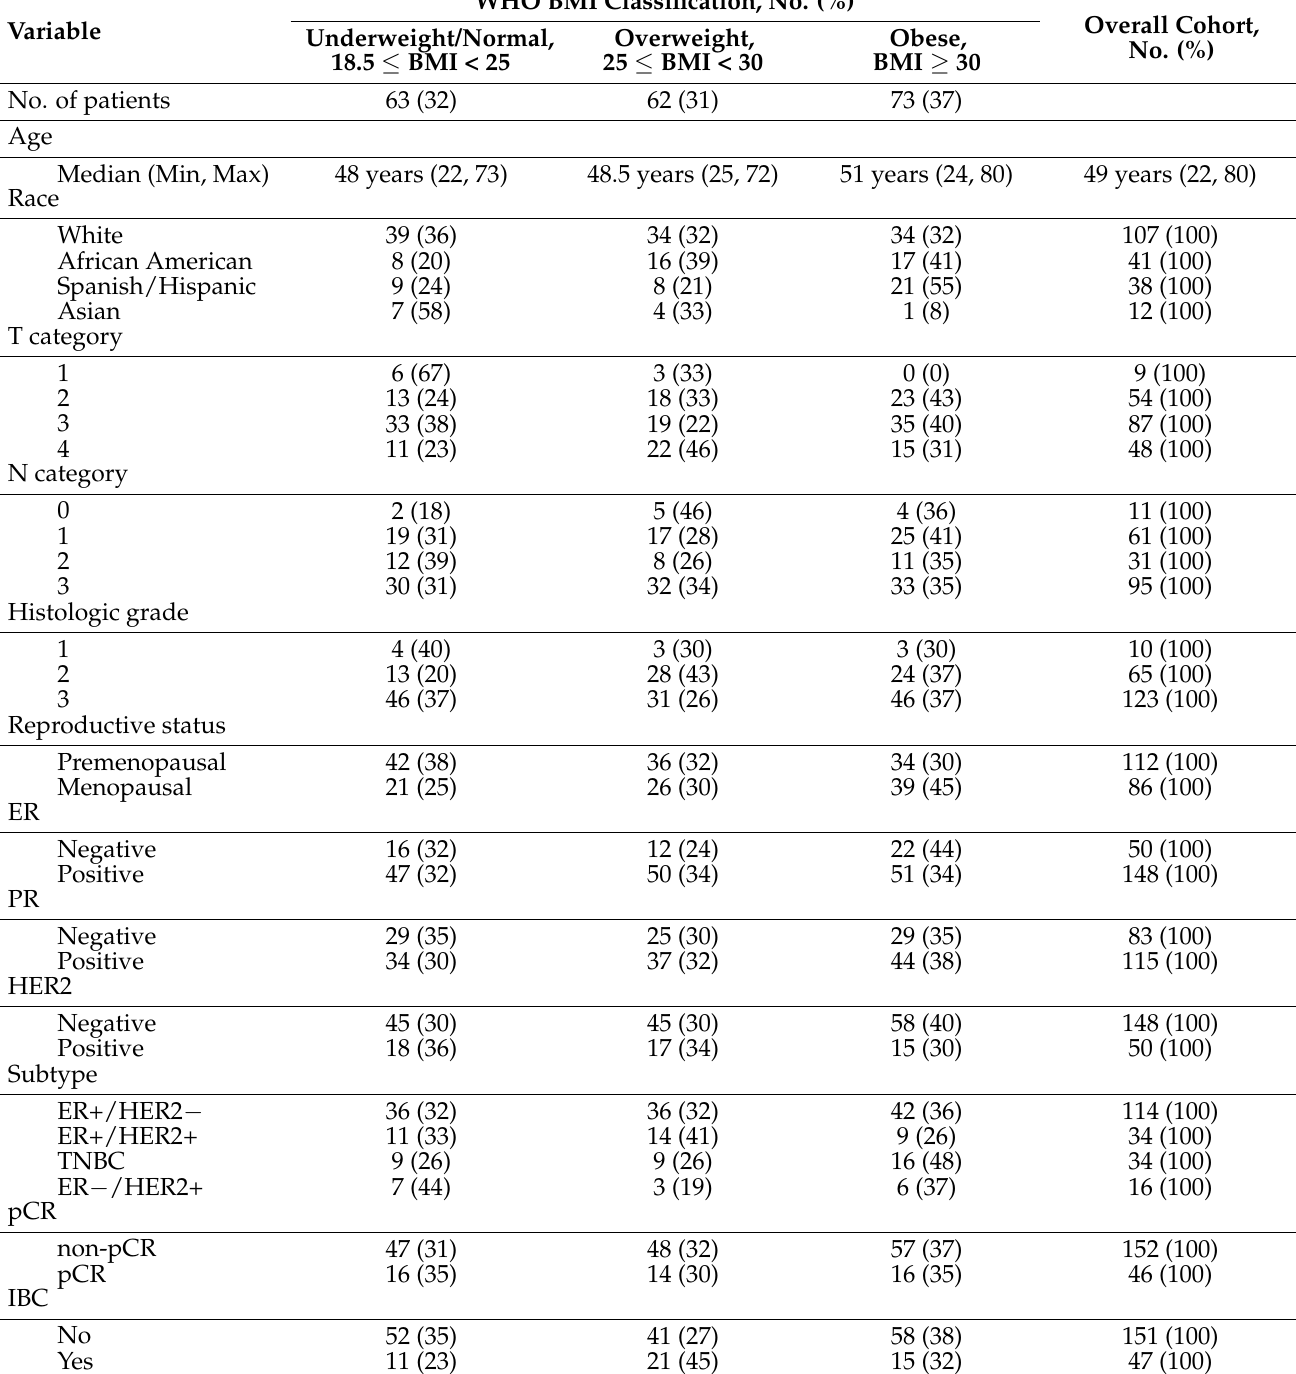
Table 1. Patient demographic and baseline characteristics ( n =